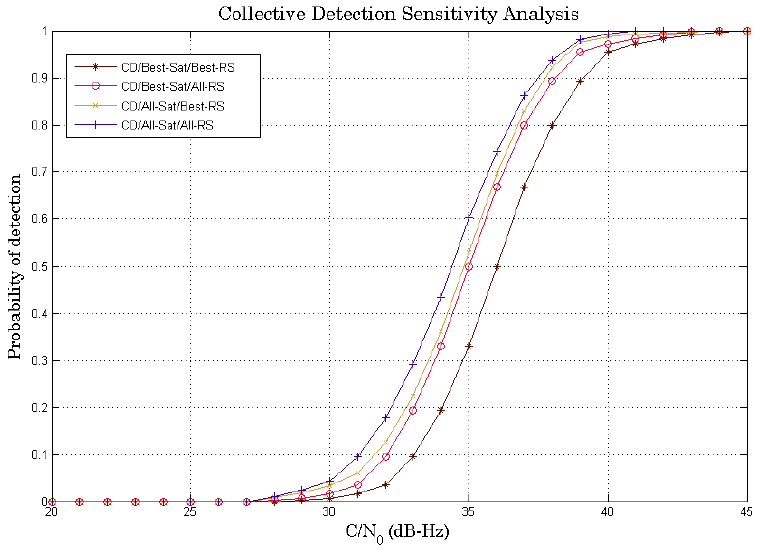
Figure 7. Sensitivity performance comparison between all four CD algorithms.